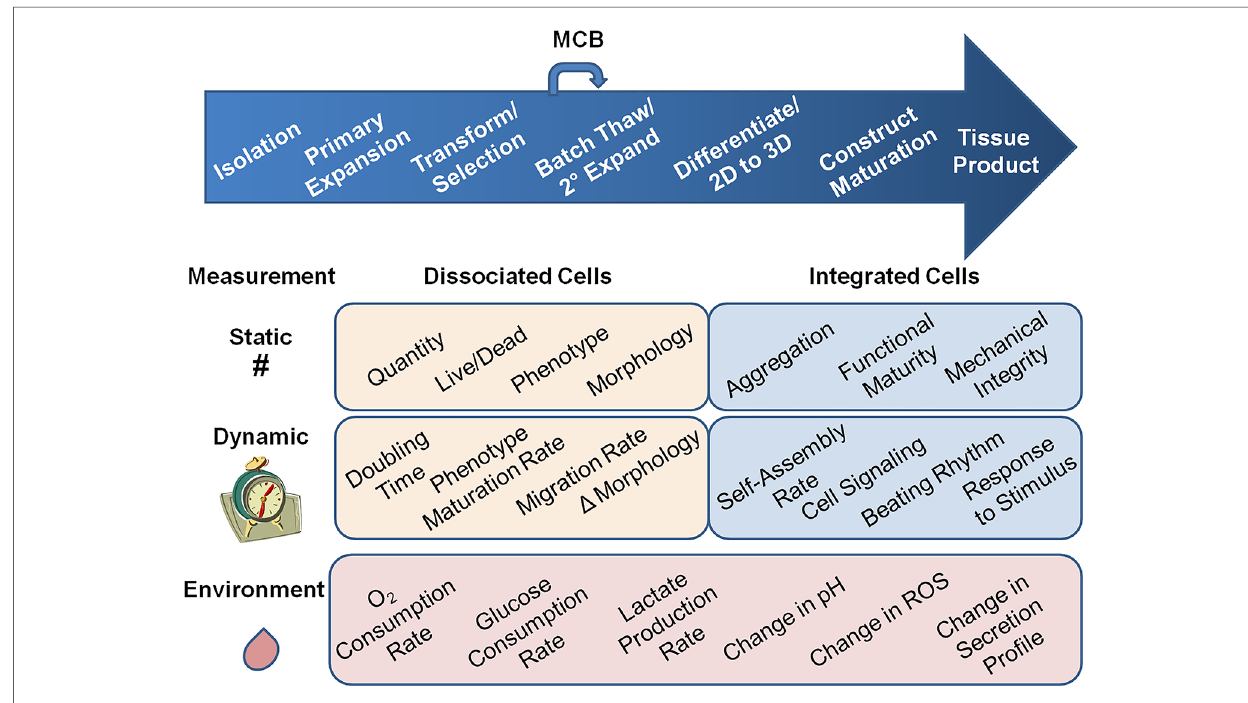
FIGURE 1 Types of measurements for regenerative medicine tissue production quality attributes. Processes for RM tissue production are as diverse as the tissues they produce; however many of them have these general steps. Cells are isolated, expanded in vitro , and some processes have manipulation steps, i.e. generation of iPSC and re-differentiation. There there is a selection step and cells may go into a Master Cell Bank (MCB) for storage, whether the process is allogeneic or patient-speci fi c. For producing the organ, the cells may undergo a secondary expansion before being loaded into a scaffold to make a construct and placed in a bioreactor. There may be more construct maturation steps as well as construct folding or assembly into higher-order structures. At each step away from simple 2D culture, measurement of the quality attributes, and the needs of cells, gets more dif fi cult. There are static measures like cell number, live/dead, phenotype, and morphology that are well established for 2D cultures, but need more development for higher order structures. In addition, there are static quality attributes like cell aggregation, appearance of functional maturity, and mechanical integrity that could be applied to cells integrated into 3D and higher-order structures. Dynamic measurements add the element of time. Static measurements in 2D cultures become doubling time, maturation rates, migration rates, and change in morphology. Dynamic measures may better predict later product QAs. In addition to these attributes, cells integrated into constructs may have self-assembly rates, cell signaling changes, and functional changes like acquiring a heartbeat, and responses to stimulus that re fl ect proper whole-organ function. Each of these attributes need to be measured as a re fl ection of cell quality. Environmental QAs like oxygen and glucose consumption rate, lactate production rate, change in pH, and reactive oxygen species (ROS), can be critical process parameters (CPPs). Also production of soluble factors that indicate organ function, like urine or insulin could be measured in the liquid phase of the culture. These quality attributes are re fl ective of the overall function of the organ, but are indirect measures of cell health. They are also rarely measured in process steps before introduction to the bioreactor, but perhaps if they were used throughout the production process, they could help predict product quality